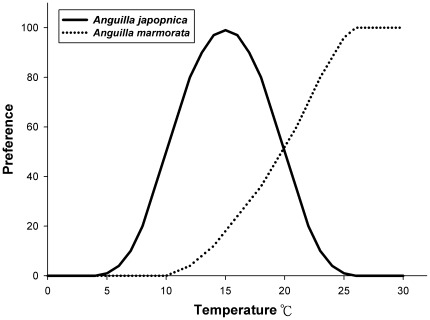
Water temperature preferences for A. japonica and A. marmorata recruitments.